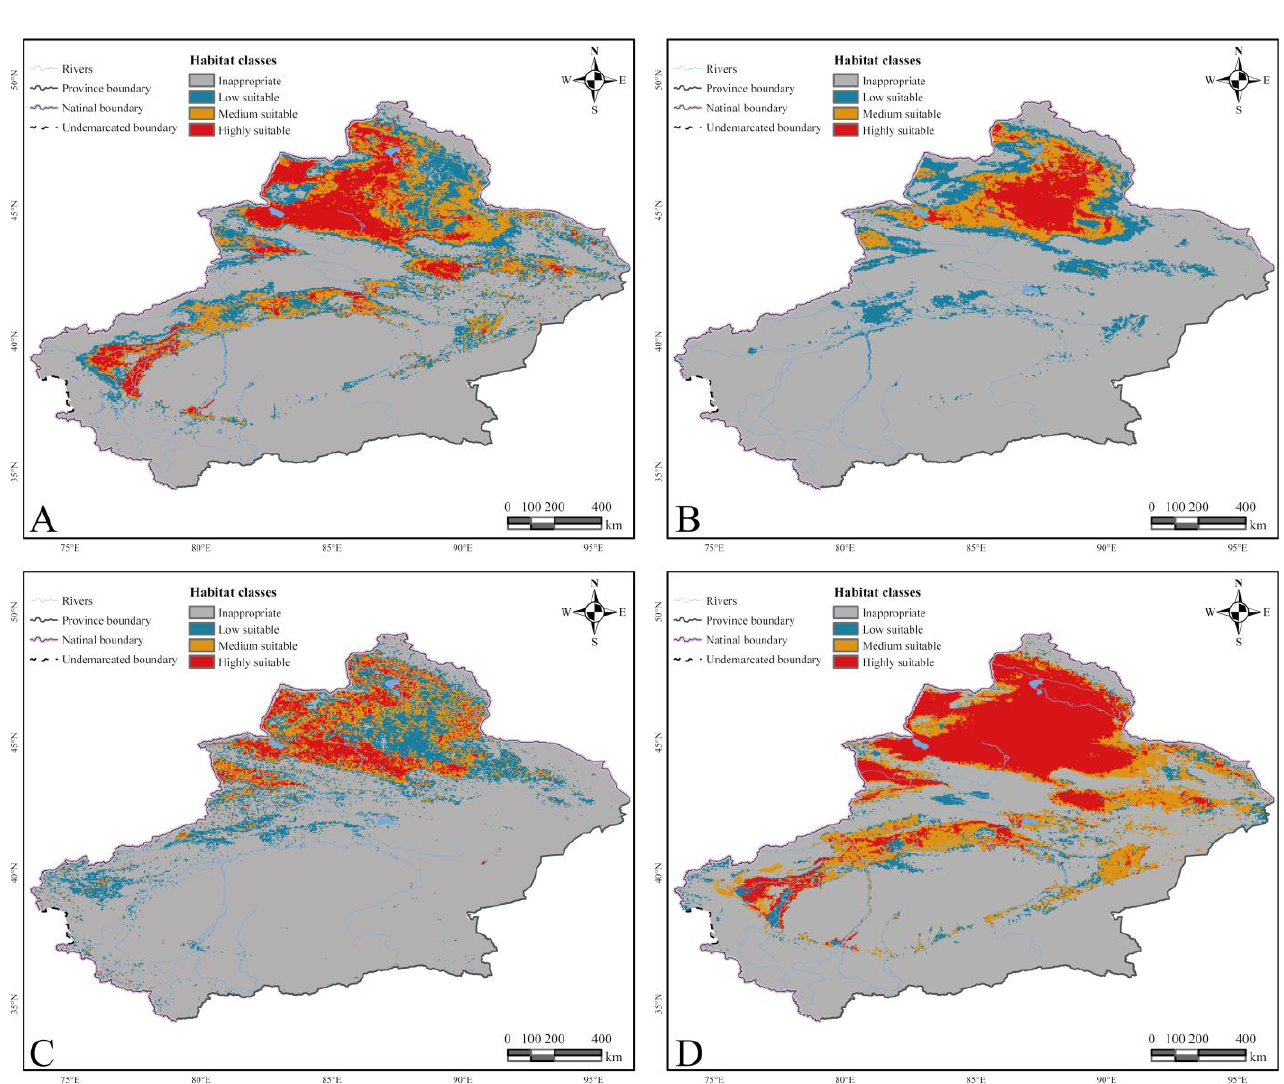
Figure 7. The current predicted distributions of C. deserticola and its hosts. ( A ) The current distribution of H. ammodendron ; ( B ) the current distribution of H. persicum ; ( C ) the current distribution of C. deserticola with AH; ( D ) the current distribution of C. deserticola with HO. We have taken into account the actual distribution of the host plant on the basis of the AUC values and the HO strategy adequately reflects the impact of host distribution. We therefore used the HO strategy as a basis for delineating the C. deserticola nature reserve and based the delineation of the reserve and functional areas on changes in habitat area under future climate (Figure 8). The AH/HO means the strategy of abiotic and host factors or host factors